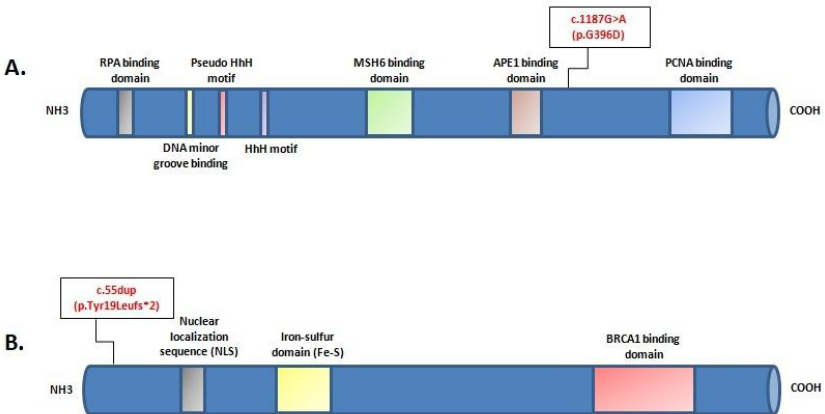
Figure 3. Locationof c.1187G>A (p.G396D) mutation in the protein structure of MUTYH ( A ); location of c.55dup (p.Tyr19Leufs*2) mutation in the protein structure of BRIP1 ( B ).The position of each mutation is shown with respect to domains of functional significance in the translated protein.